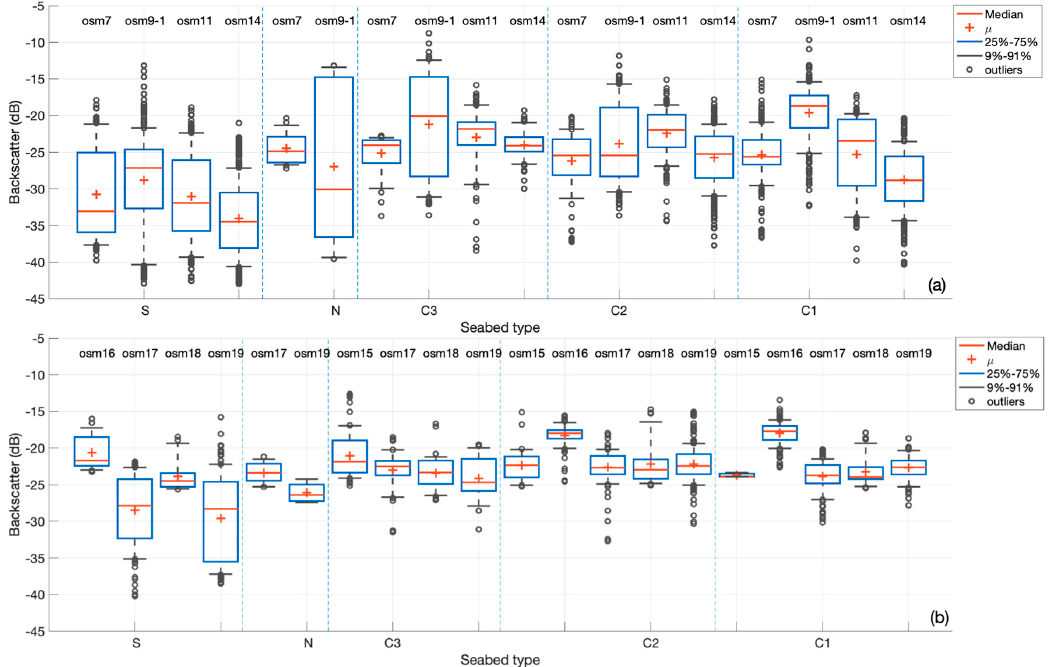
Figure 9. Box-and-whisker diagrams showing relative backscatter intensity for each seabed type in the surveyed seamounts using acoustic data and optical results: ( a ) Type 1 seamounts (OSM 7, 9, 11, and 14), ( b ) Type 2 seamounts (OSM 15, 16, 17, 18, and 19). Box-and-whisker plot shows the median (bar), mean (plus), and interquartile (25–75%) range and outliers (circle) being 1.5 times this range.